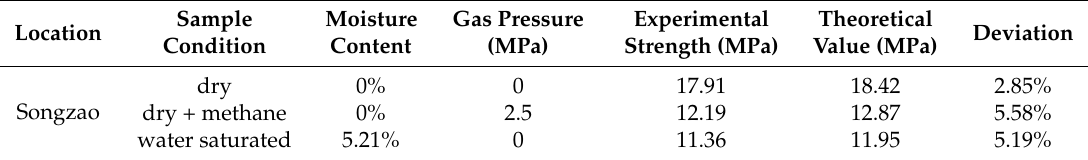
Table 5. Experimental results of triaxial compression strength test for dry, dry + methane and only water saturated samples of Songzao.